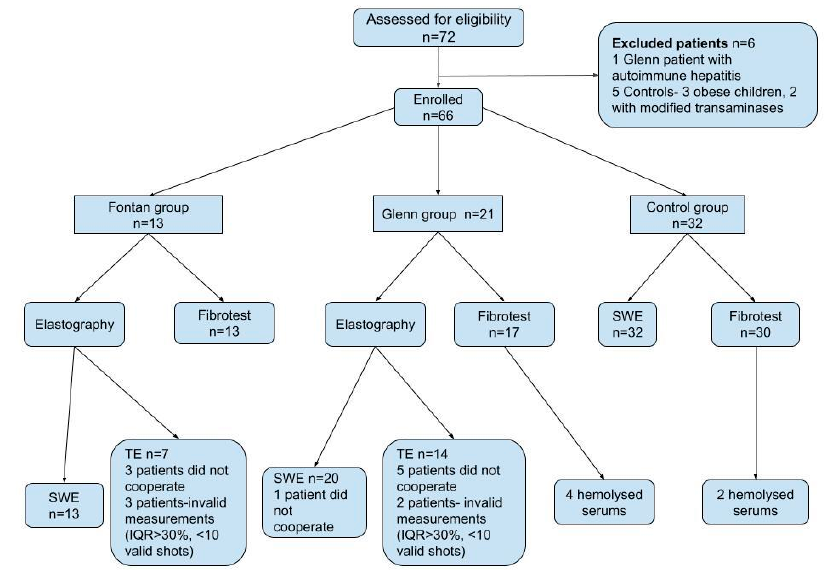
Figure 1. Flowchart of included patients and main investigations. 3.2. Fontan Group The E median values determined by SWE in the Fontan Group were significantly higher than the values of the control group (4.85 kPa vs. 3.91 kPa, p = 0.0049). Similarly, V median values were higher in the Fontan group compared to controls (1.25 m/s vs. 1.12 m/s, p = 0.01) (Figure 2, Table 2).